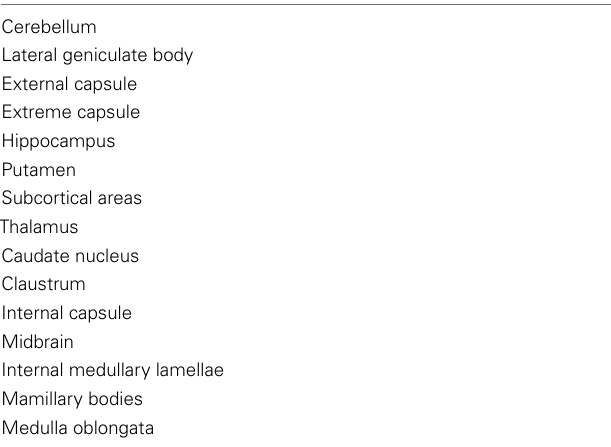
Table 1 | CNS lesions on EPM.